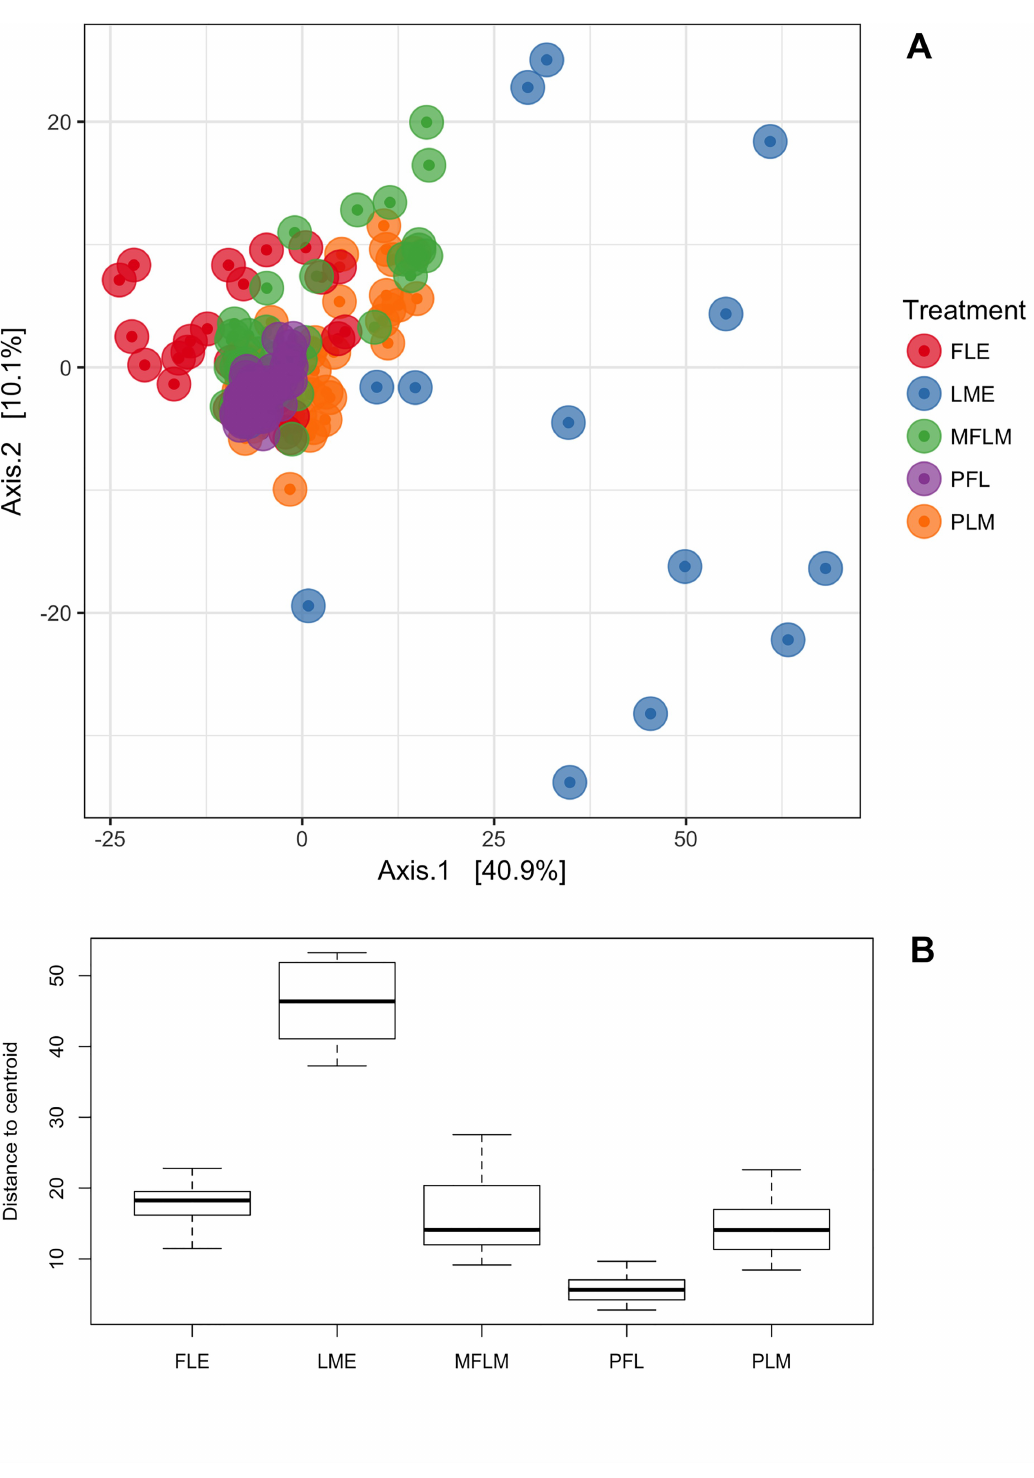
PLOS ONE | https://doi.org/10.1371/journal.pone.0217296 May 20, 2019 6 /